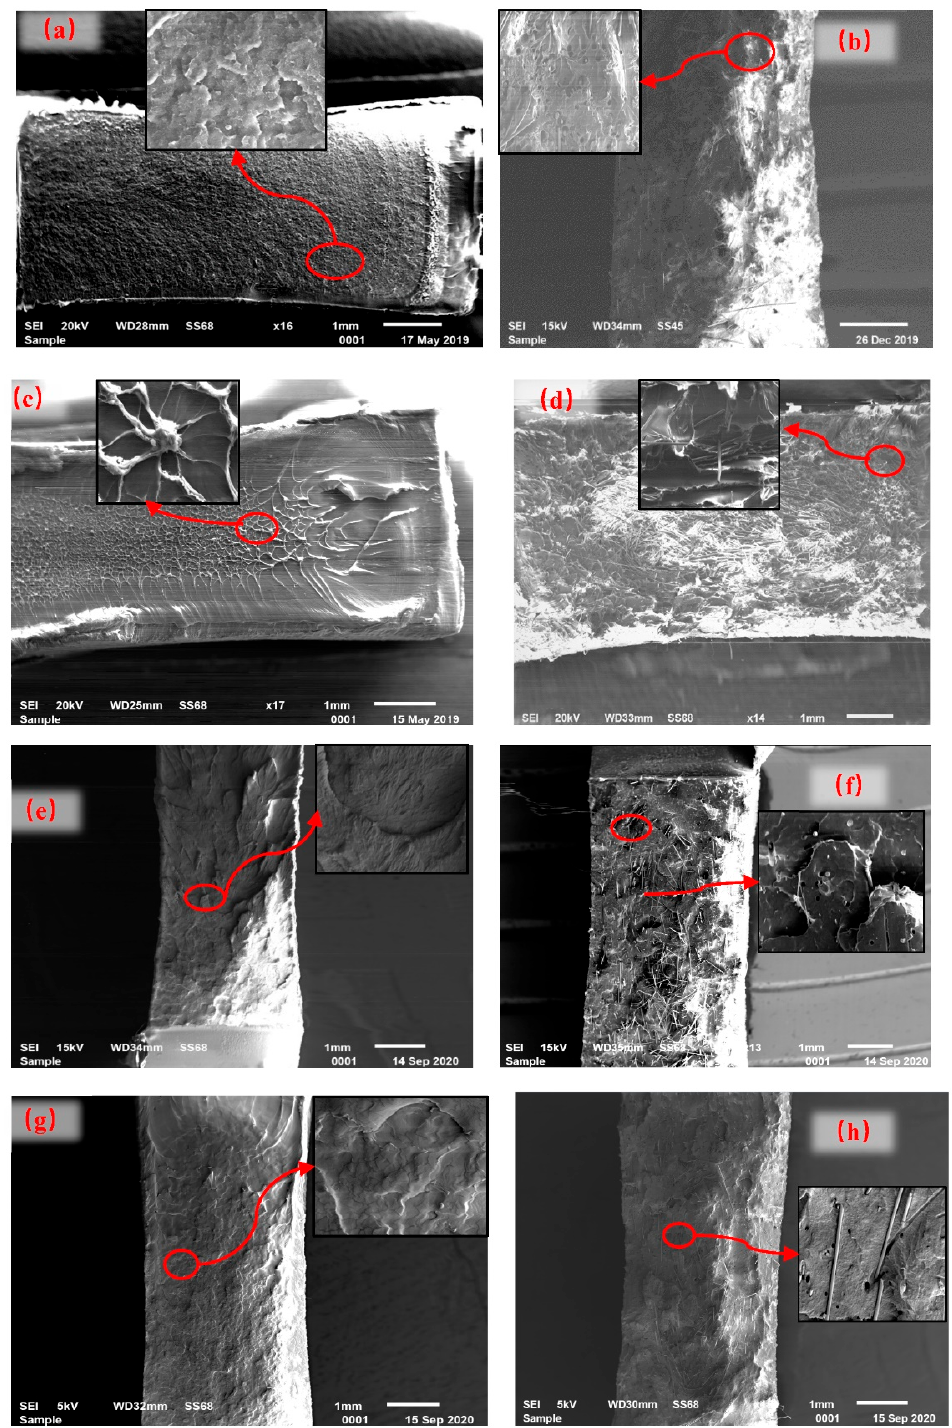
Figure 4. Fracture surfaces for the neat polymers and LFT composites. ( a ) 8008; ( b ) C − 8008 − 2.8%; ( c ) 100S; ( d ) C − 100S − 2.8%; ( e ) K8303; ( f ) C − K8303 − 2.8%; ( g ) C4220; ( h ) C − C4220 − 2.8%.